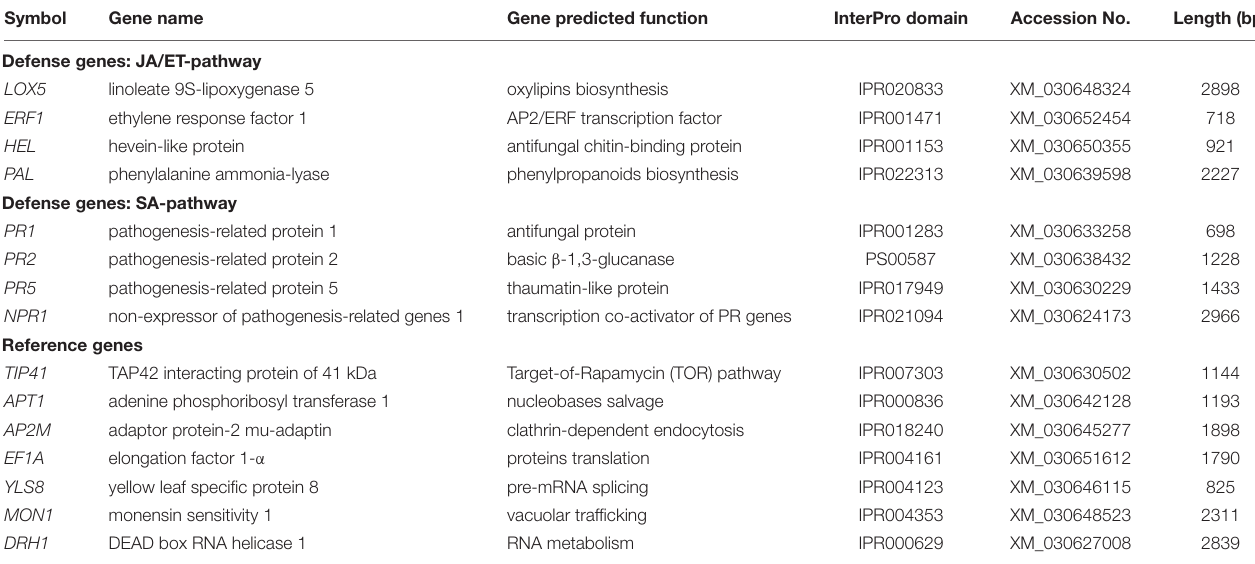
TABLE 1 | Description of cannabis putative defense genes and candidate reference genes.